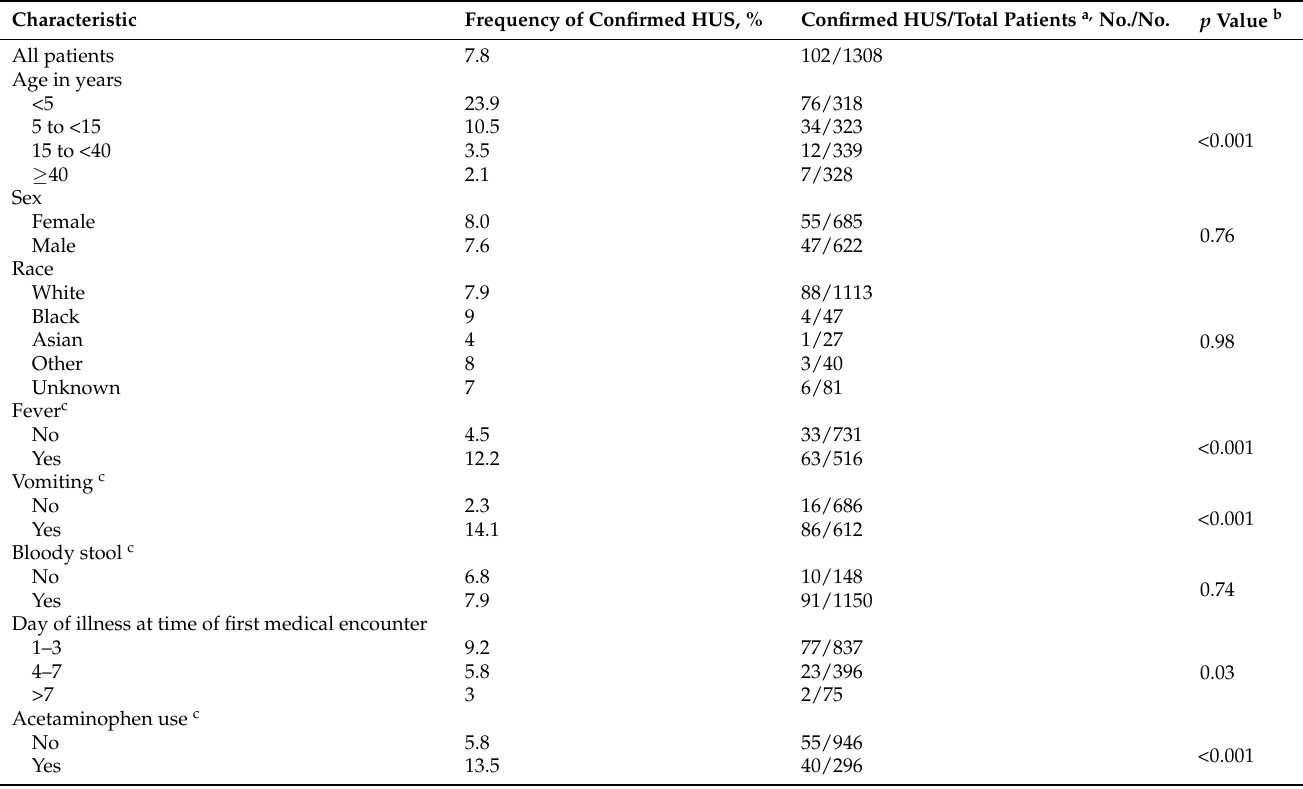
Table 2. Frequency of confirmed HUS by demographic and clinical